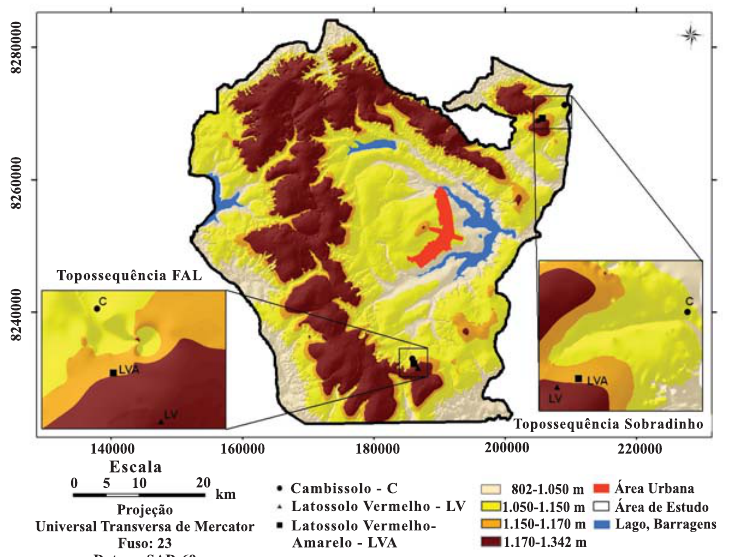
Figura 1. Localização das topossequências estudadas nas Chapadas Elevadas do Distrito Federal (Extraído de Barbosa,